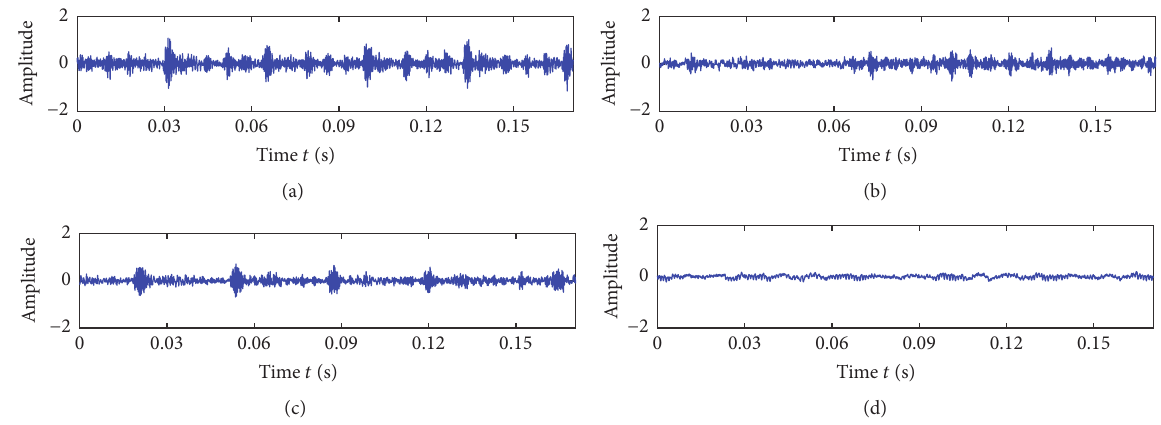
Figure 5: Raw vibration signal: (a) inner race fault, (b) ball fault, (c) outer race fault, and (d) healthy state.